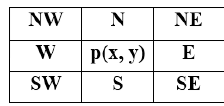
Figure 3: Central pixel p ( x , y ) with eight neighborhood pixel